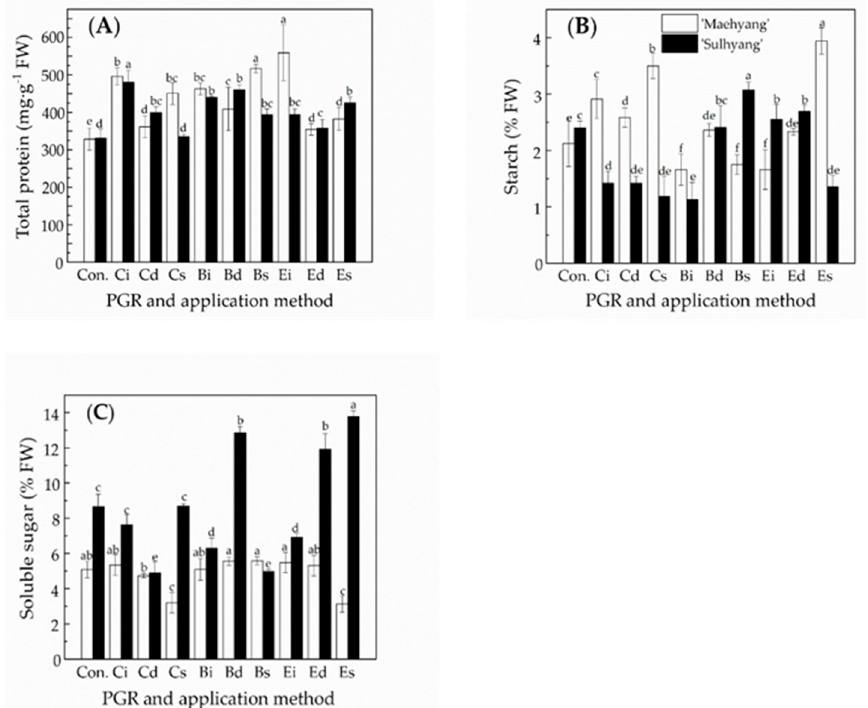
Figure 2. The effects of chlormequat chloride (CCC), 6-benzylaminopurine (BA), and ethephon (ETH) at a concentration of 100 mg · L − 1 and their application method (injection, drench, and spray) on the content of ( A ) total protein, ( B ) starch, and ( C ) soluble sugars in leaves of strawberries ‘Maehyang’ and ‘Sulhyang’ sampled 30 days after treatment initiation. Vertical bars indicate the standard error ( n = 3). Means accompanied by different letters are significantly different ( p < 0.05) according to the Duncan’s multiple range test: The letters C, B, and E stand for CCC, BA, and ETH, respectively; I, d, and s stand for injection into crowns, medium drench, and foliar spray, and Con. is the